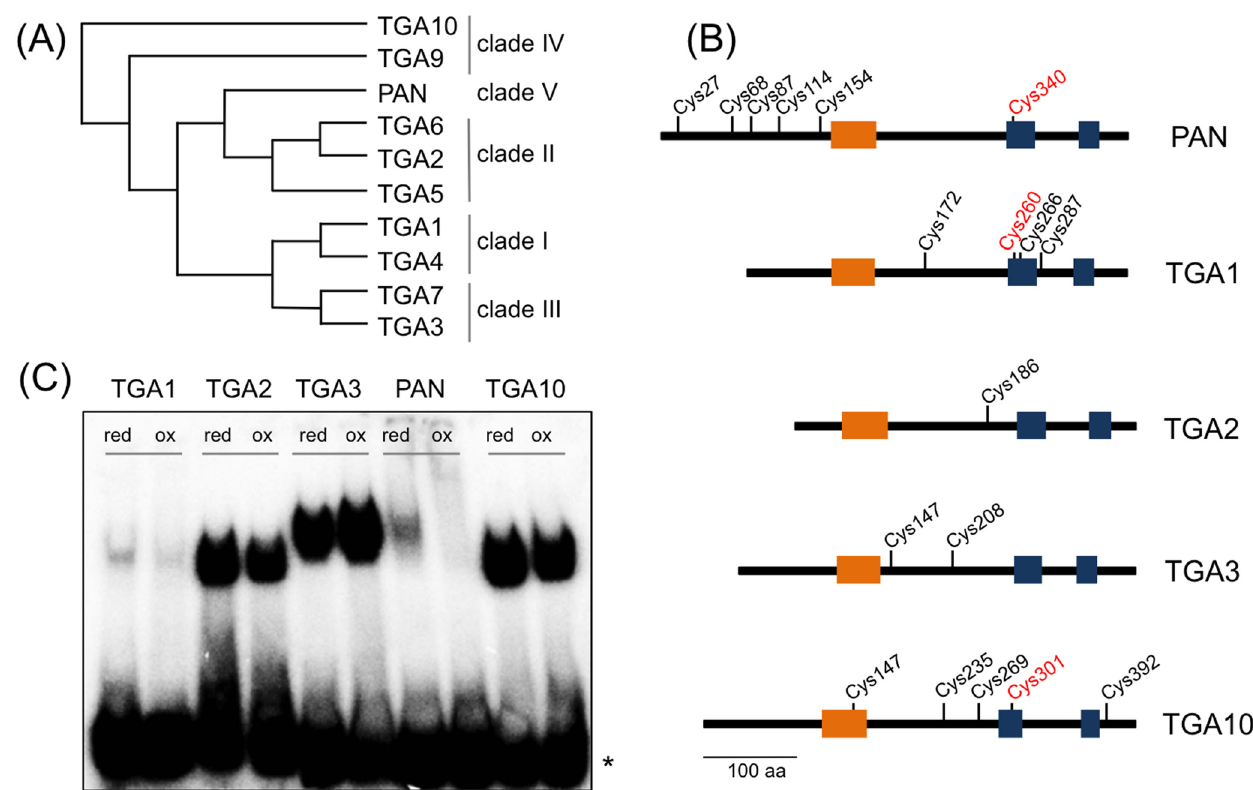
Fig 2. Redox-dependent binding of selected Arabidopsis TGA TFs to the AAGAAT motif. (A) Cladogram of Arabidopsis TGA TFs indicating clade memberships. (B) Schematic representation of selected TGA TF family members and respective cysteine residue positions. Orange boxes mark the bZIP domain and blue boxes two glutamine-rich regions. Cys340, Cys260 and Cys301 (red) are localized in a conserved position in the first glutamine-rich region. (C) Gel retardation analysis of selected TGA proteins incubated with the AAGAAT probe under reducing (0.9 mM DTT; red) or oxidizing (2 mM diamide; ox) conditions. Asterisk marks unbound AAGAAT probe.